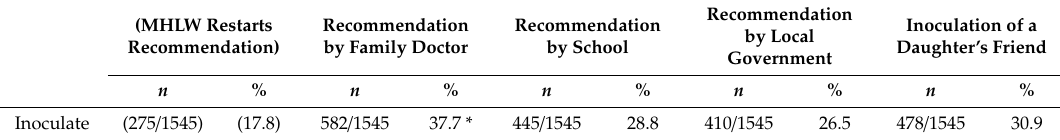
Table 3. Factors that would promote